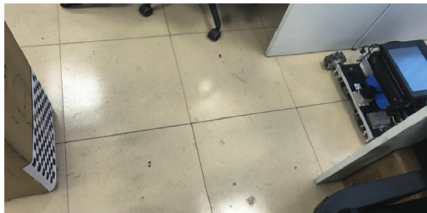
Figure 2: Calibration is performed using a calibration plate affixed to a prominent raised